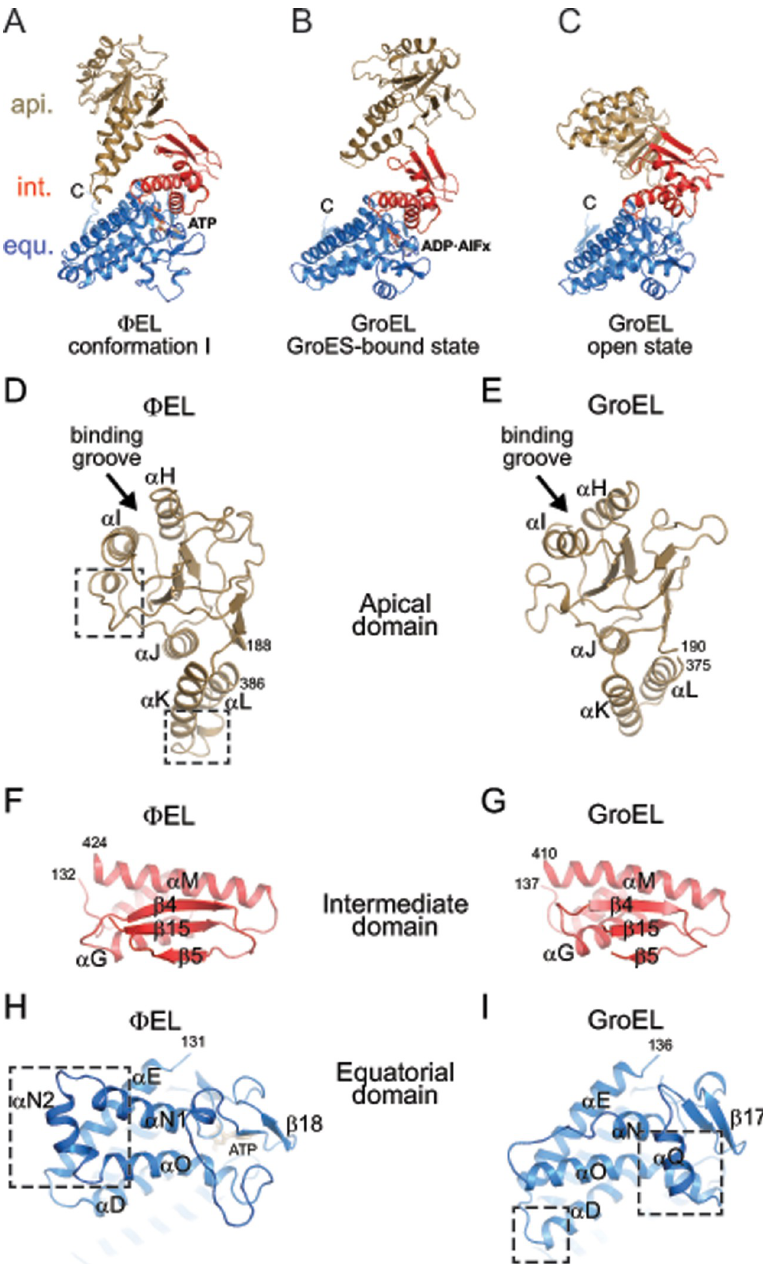
Fig 9. Comparison of the structures of ɸ EL and GroEL. (A) Subunit structure of ɸ EL (conformation I). The representation is the same as in Fig 6. (B, C) Structures of GroEL subunits from the cis (B) and trans rings (C) of the symmetric GroEL:GroES 2 complex (PDB 1PCQ) [51]. The same representation style as in panel A. (D, E) Structures of the apical domains in ɸ EL (D) and GroEL (E). Ribbon representations are shown. Remodeled regions in ɸ EL discussed in the text are highlighted in boxes. Chain termini and α -helices are indicated. Arrows point to the proposed substrate binding site in group I chaperonins. For GroEL, the PDB dataset 1XCK (apo, open state) [52] was used. (F, G) Structures of the intermediate domains in F EL (F) and GroEL (G). Chain termini and selected secondary structure elements are indicated. (H, I) Structures of the equatorial domains in ɸ EL (H) and GroEL (I). Ribbon representations are shown. A view from the ring-ring interface is shown. Large insertions in the respective structure involved in inter- ring contacts are highlighted in boxes.